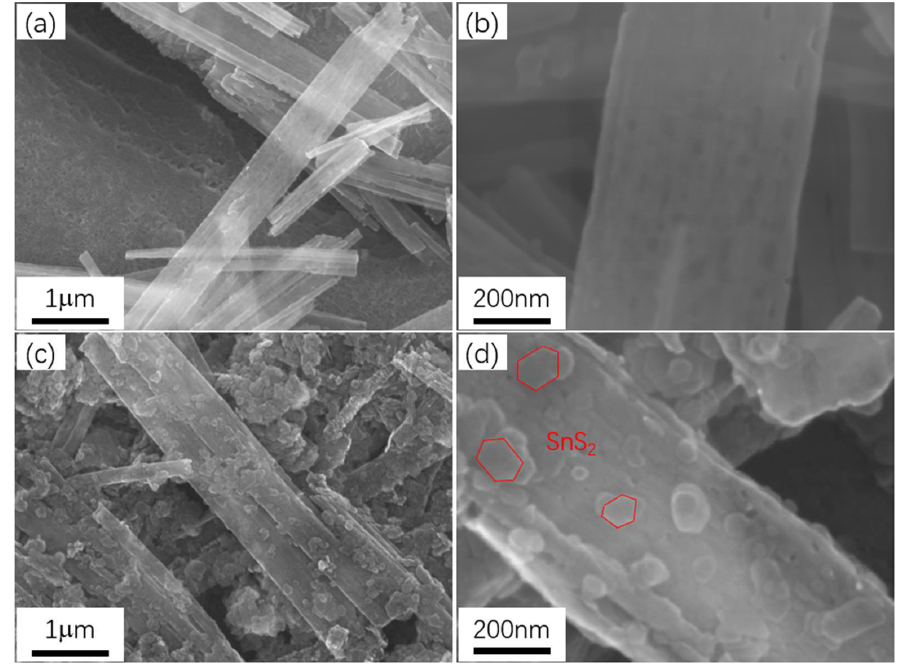
Figure 3. SEM images of ( a , b ) the TiO 2 nanobelts and ( c , d ) the TiO 2 -SnS 2 .